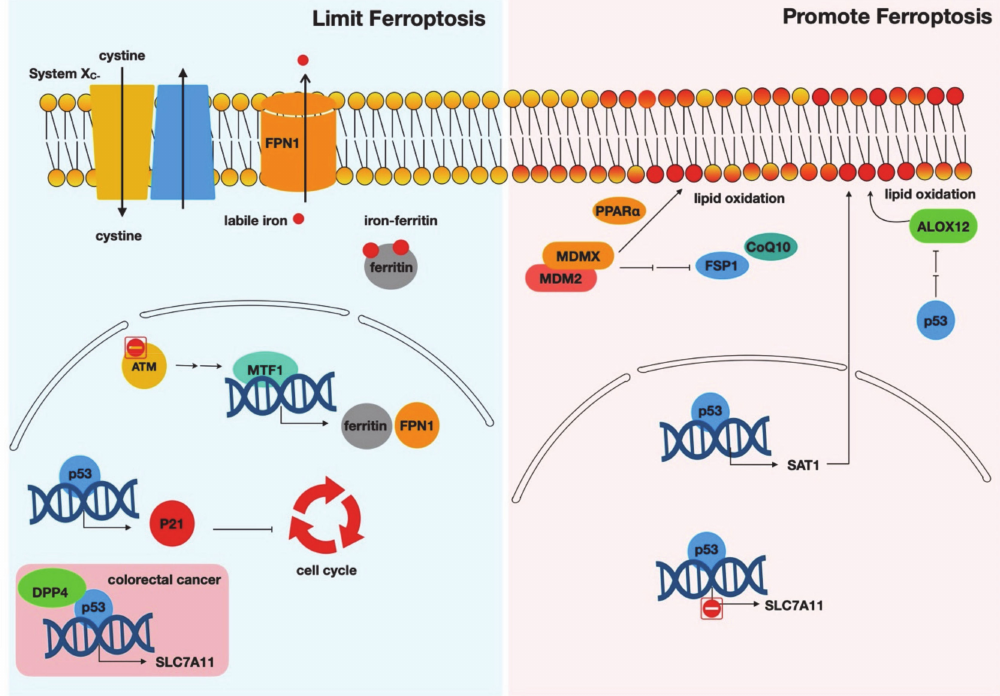
Figure 1. Canonical DNA damage response (DDR) components in